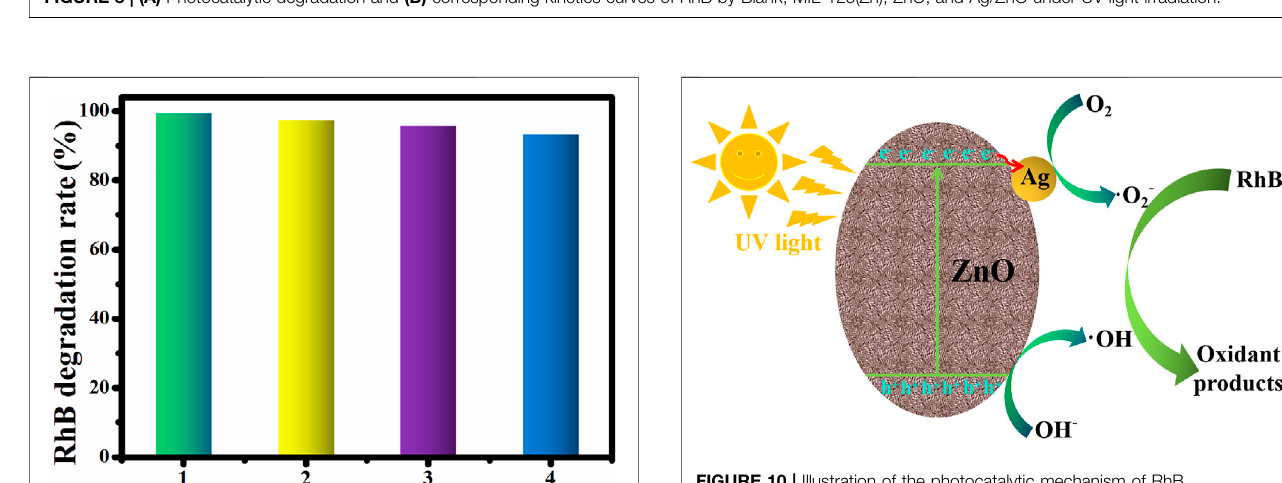
FIGURE 10 | Illustration of the photocatalytic mechanism of RhB degradation on the Ag/ZnO photocatalyst under UV light